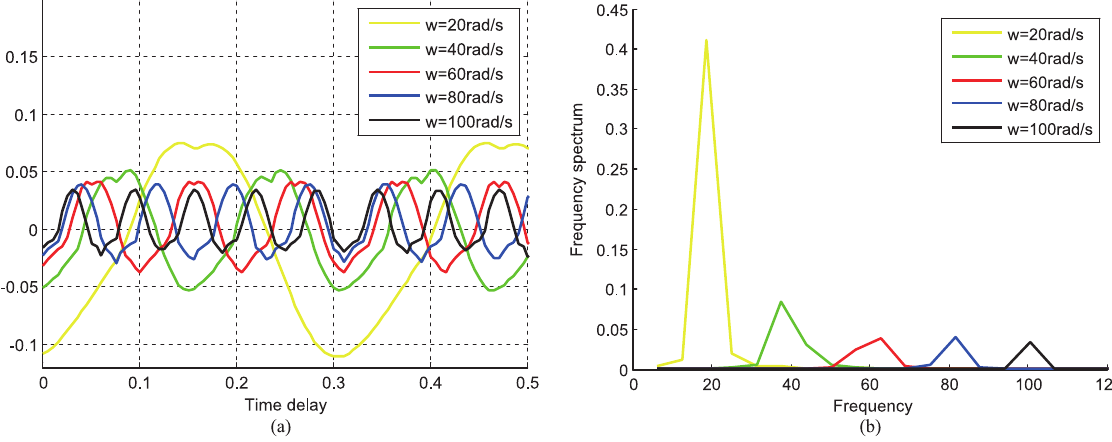
Fig. 10. Effect of time delay on the stability of DDBG DVA, (a) the largest values of the real parts of characteristic roots; (b) frequency